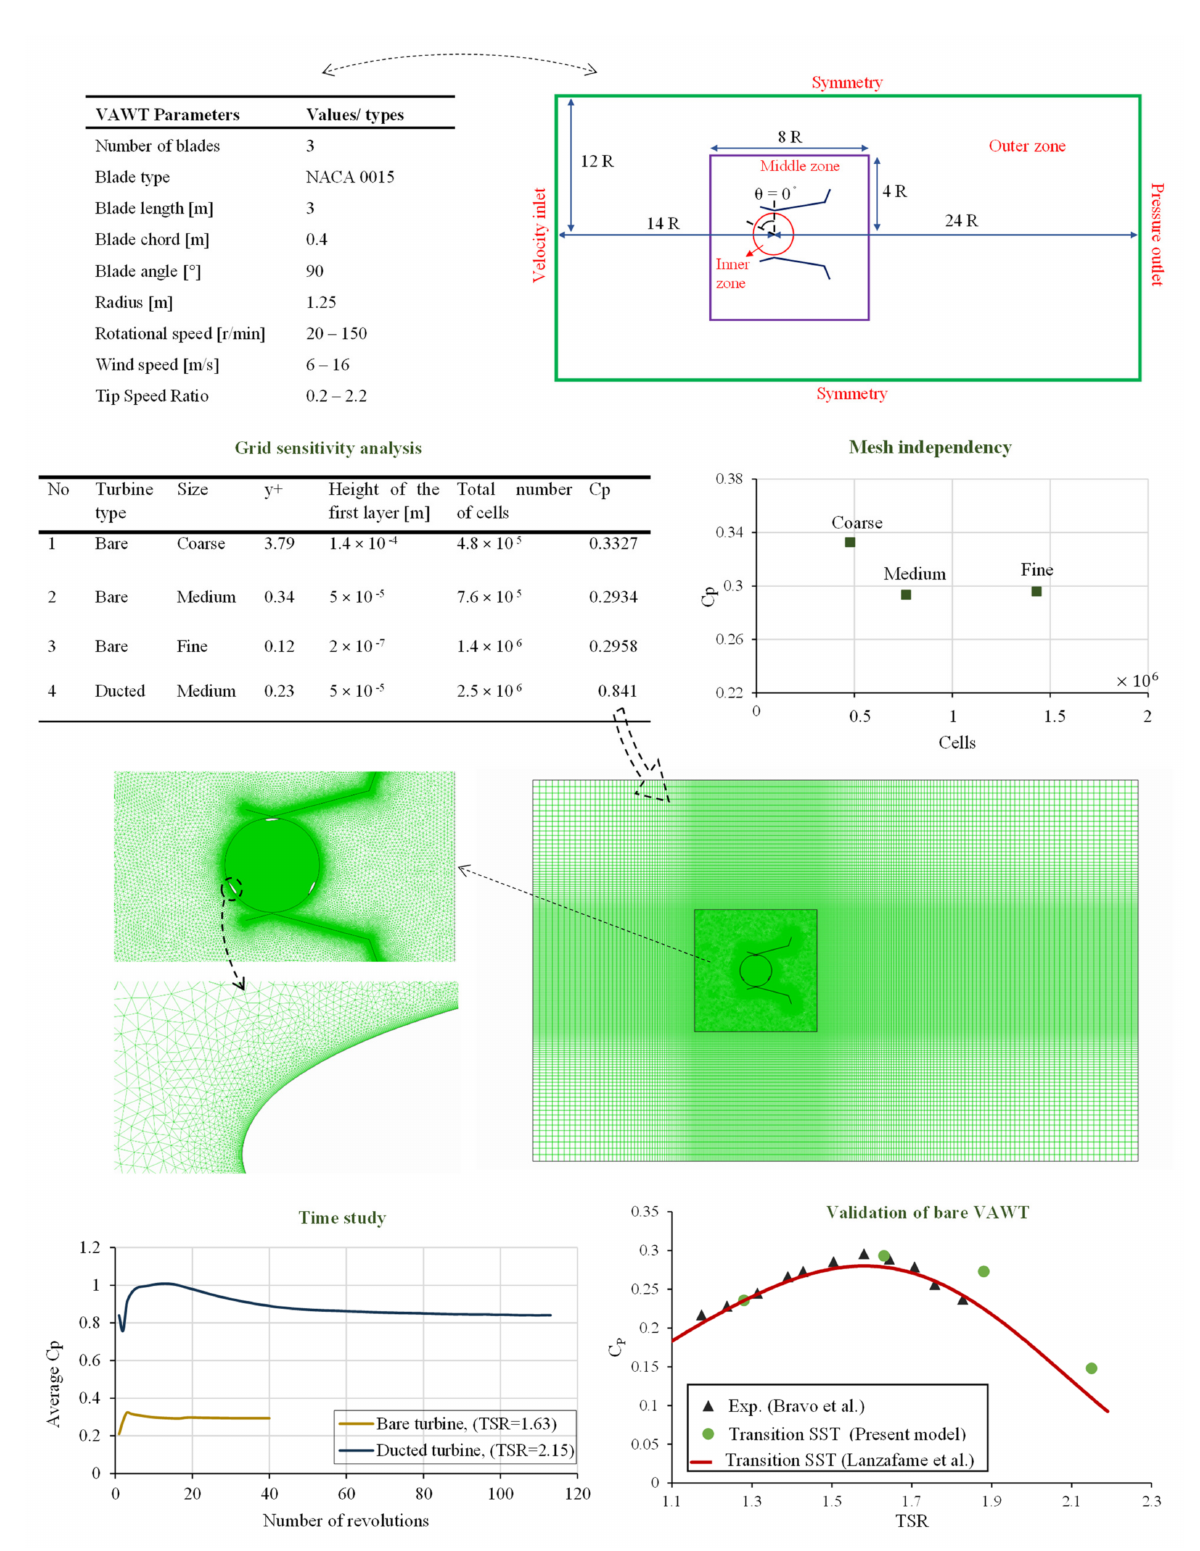
Figure 3. Numerical domain of ducted wind turbine and Bare wind turbine validation with the experimental data of Bravo et al. [47] and Transition SST results of Lanzafame et al. [51]. The two-dimensional, transient, and incompressible equations, the continuity equation derived from the conservation of mass law, Equation (1), and the Navier-Stokes equations, Equation (2), were used. Standard k - ε , k - ω and transition Shear Stress Transport